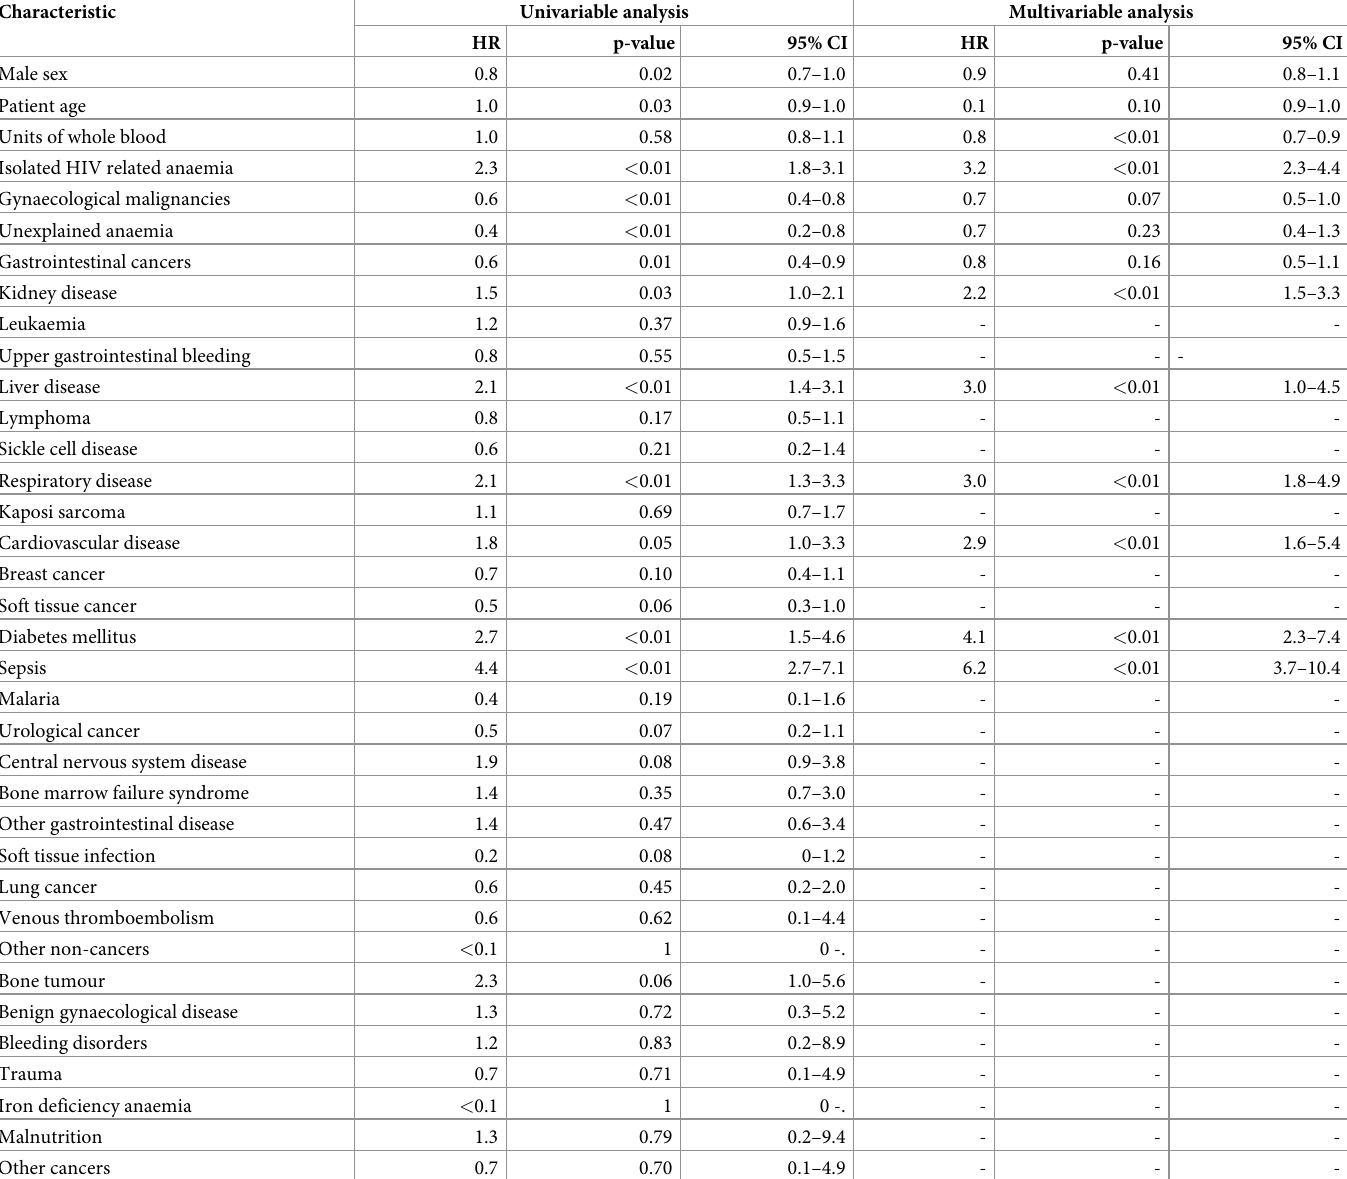
Table 2. Factors associated with